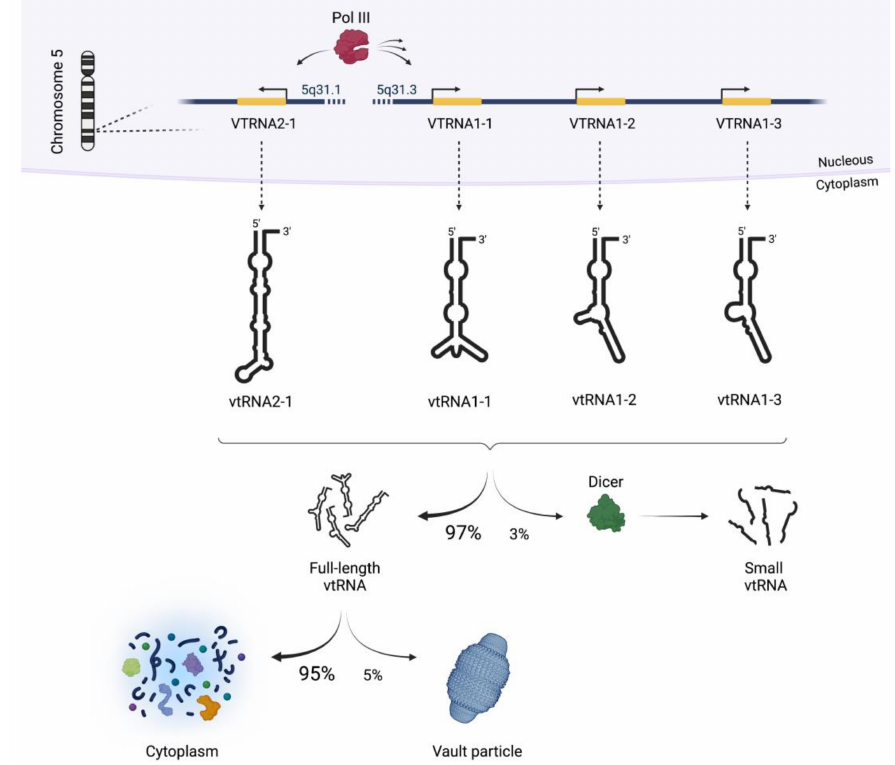
Figure 1. The human vault RNAs. The four human vault RNAs (vtRNAs) are encoded on two loci on chromosome 5 and are expressed by RNA polymerase III (Pol III). A minor fraction of the vtRNAs can be further processed by Dicer into small vtRNA fragments (~2–5% as shown for vtRNA2-1 [45]). The vast majority of full length vtRNAs locates to and functions in the cytoplasm (~95%), whereas about 5% associate with the 13 MDa large vault particle